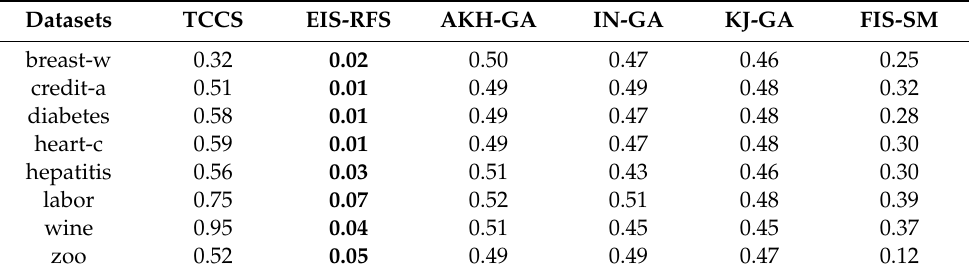
Table 12. Instance retention results of the algorithms.